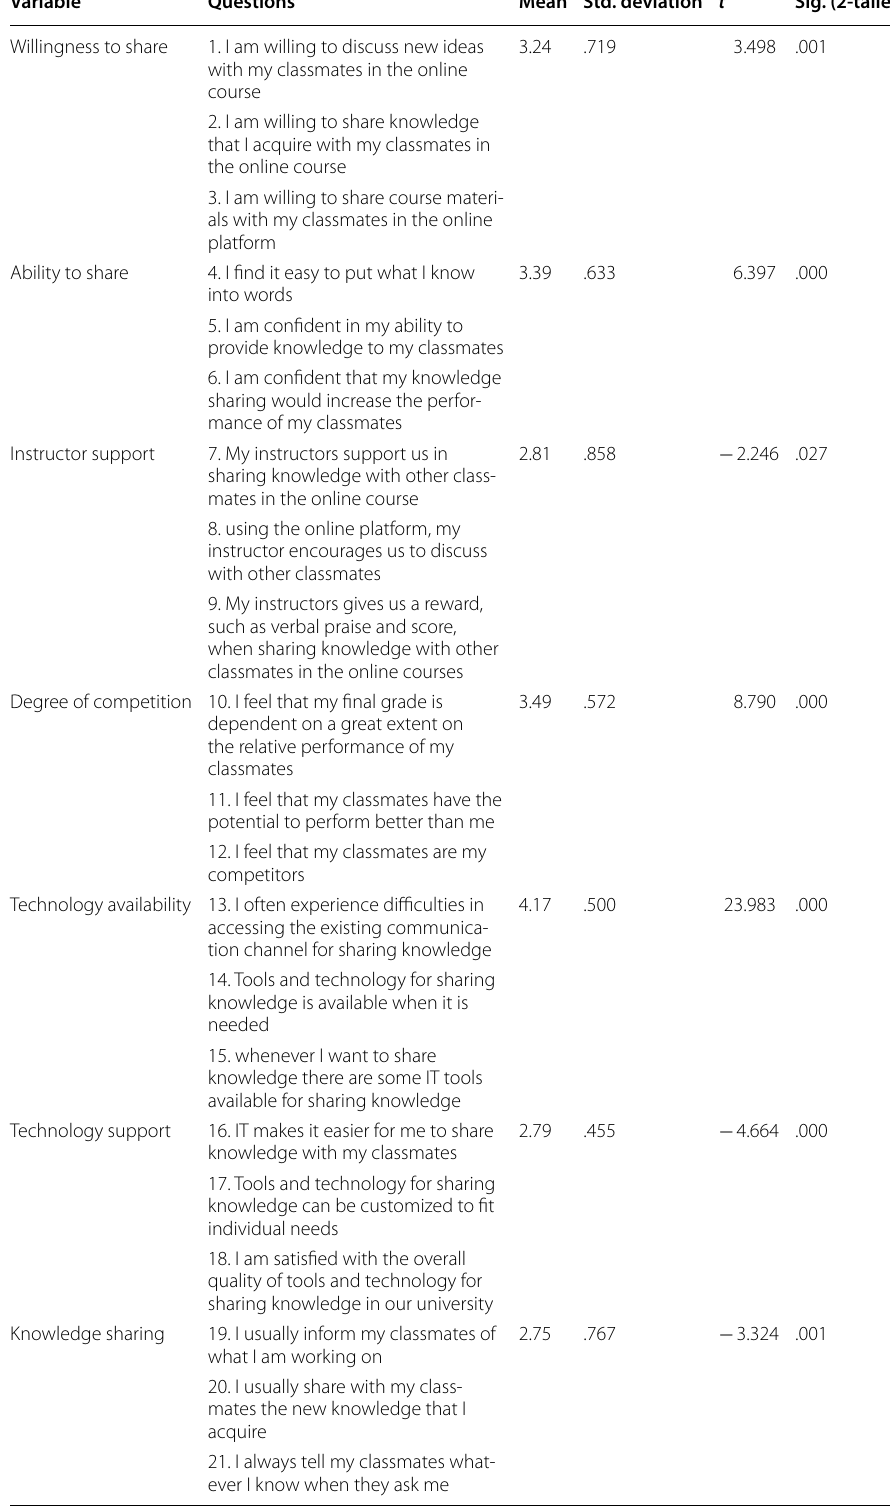
Table 2 Students’ online knowledge sharing